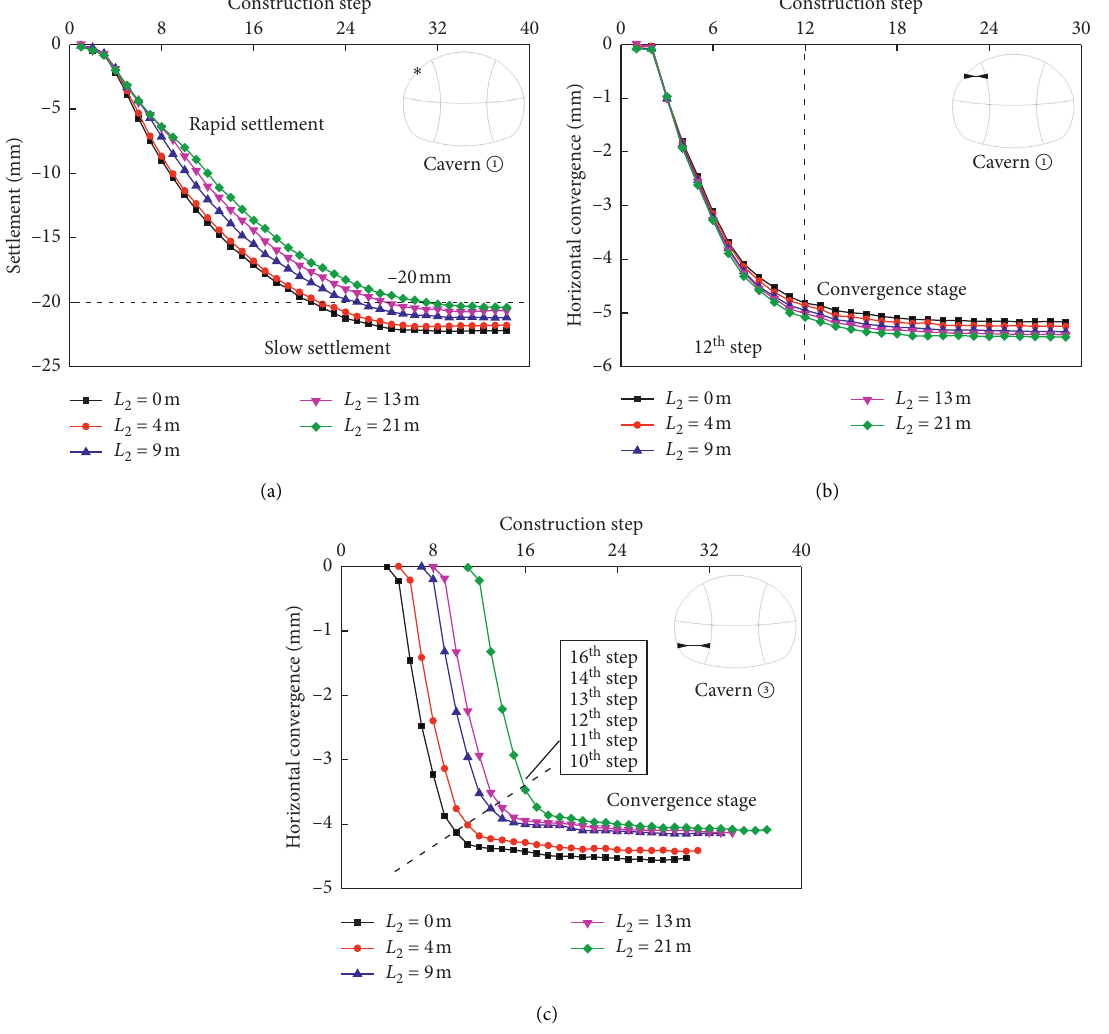
Figure 8: Horizontal deformation and convergence characteristics of the CK9 +462 section. (a) Vault settlement curve of cavern ① . (b) Horizontal convergence curve of cavern ① . (c) Horizontal convergence curve of cavern ③